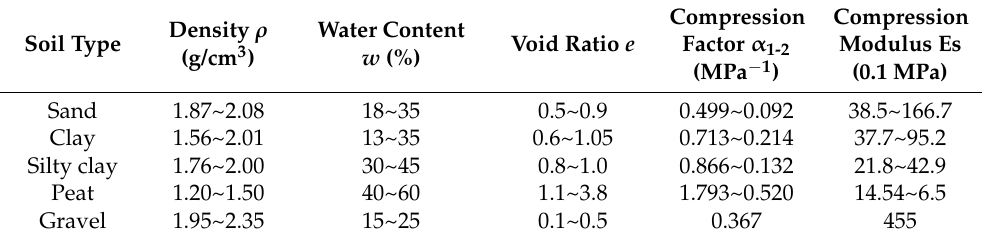
Table 5. Physical and mechanical properties index of Quaternary lacustrine sedimentary layer